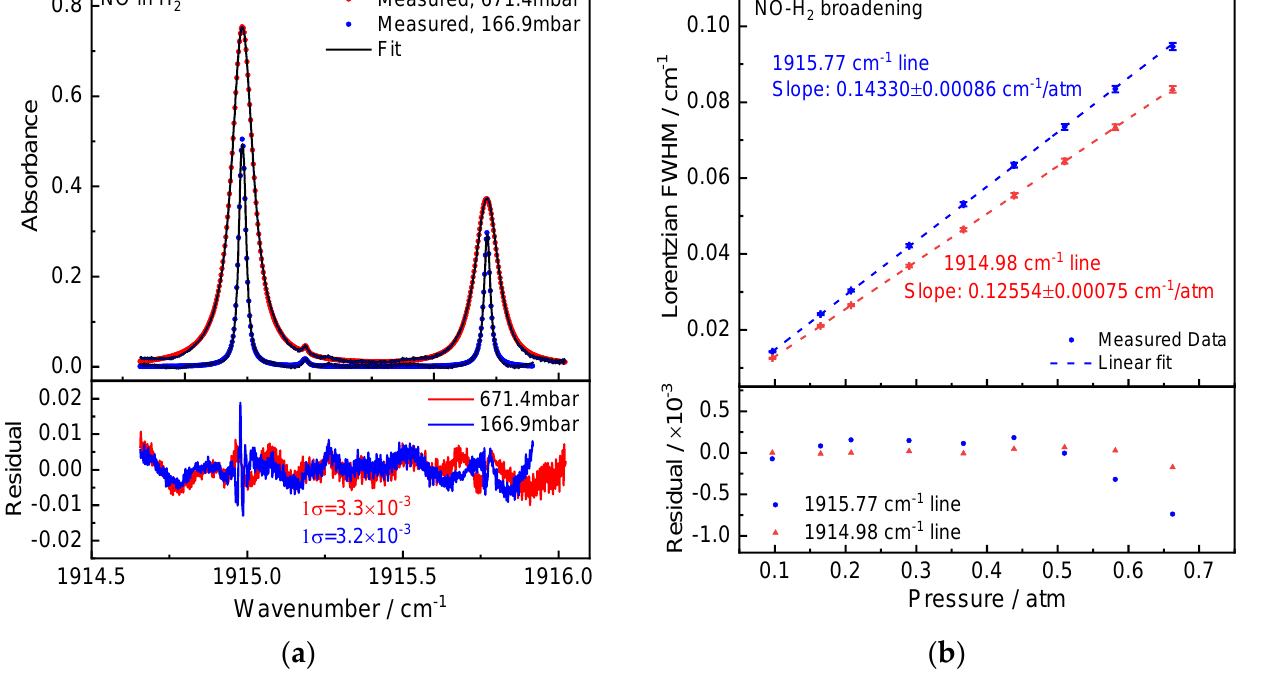
Figure 7. ( a ) Measured NO absorption spectra (20-scan averaged) in H 2 at pressures of 671.4 mbar